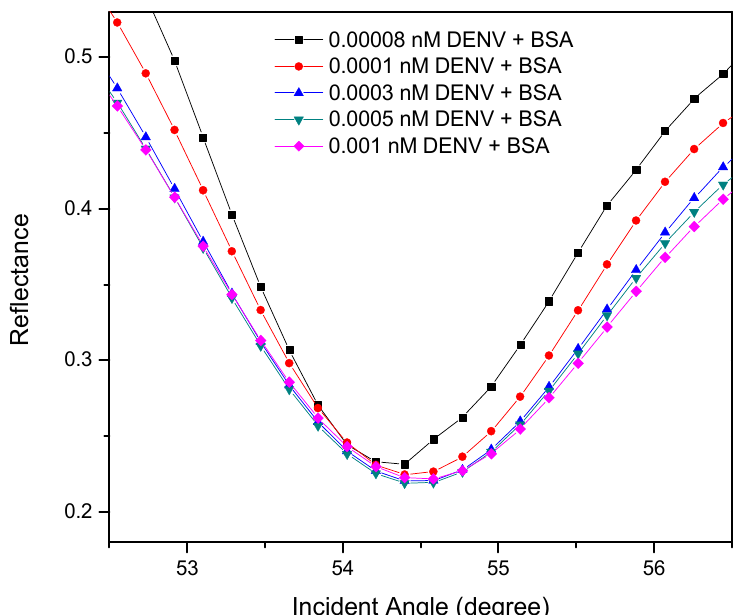
Figure 8. Experimental SPR curves for different concentration of DENV-2 E-proteins in spiked samples. Table 3. Spike and recovery results of DENV-2 E-proteins in BSA.